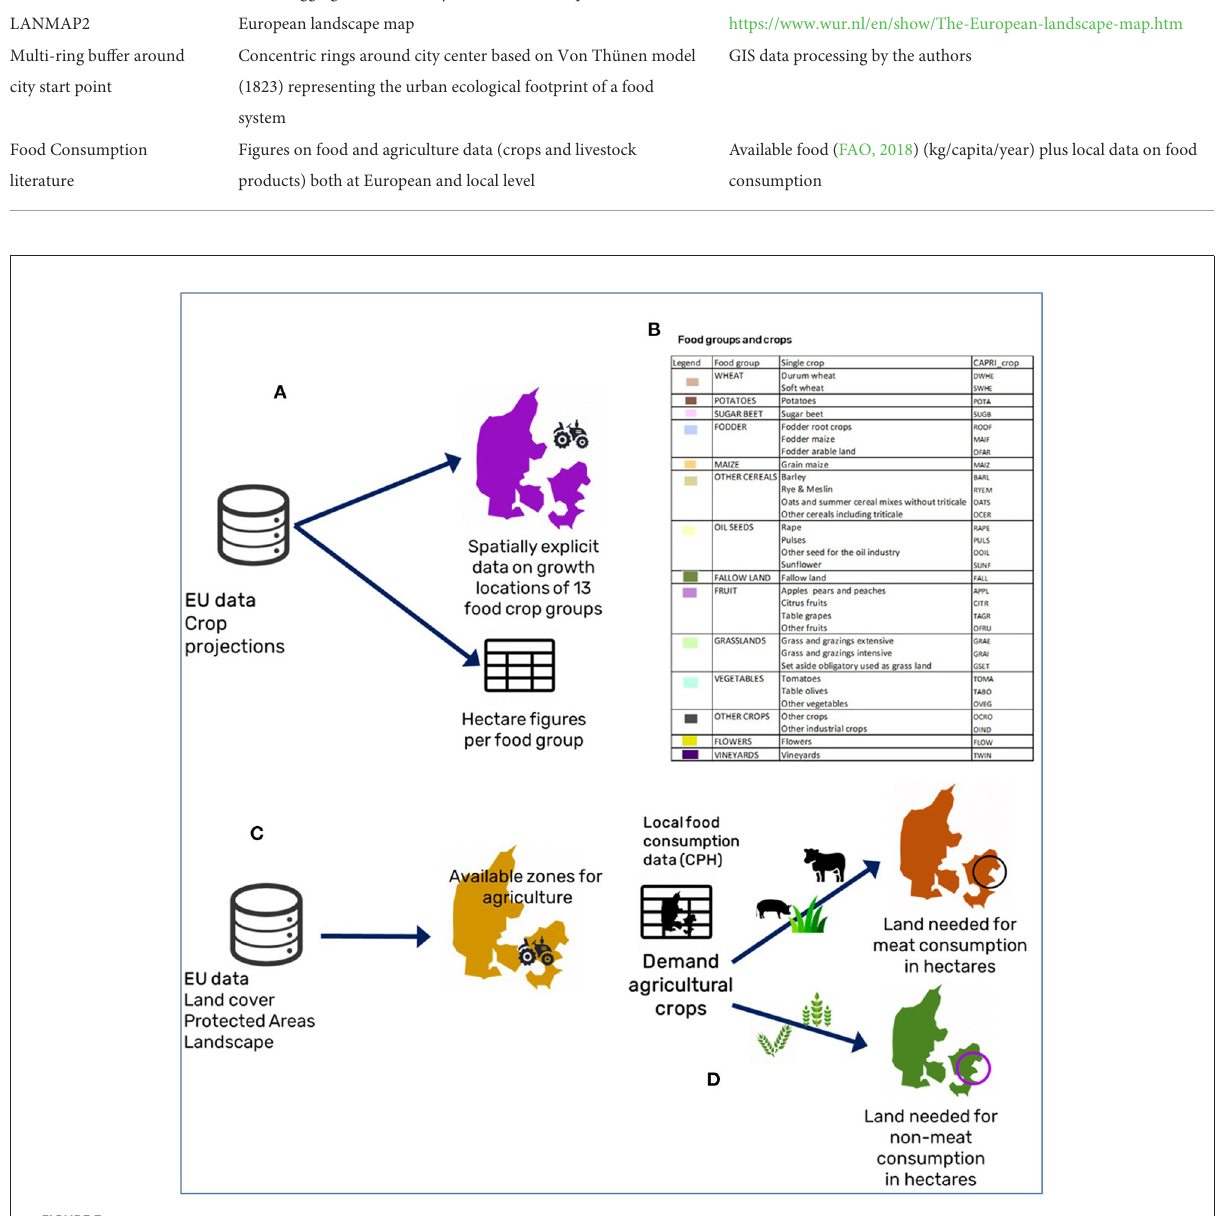
FIGURE3 Determining the footprint of urban food consumption. (A) Steps to generate a map of growth locations for 13 food crop groups. (B) A food group is an aggregation of specific crops based on the table of food groups and crops. (C) Steps to generate a map of available zones for agriculture. (D) Determining the amount of land needed for animal- and plant-based food